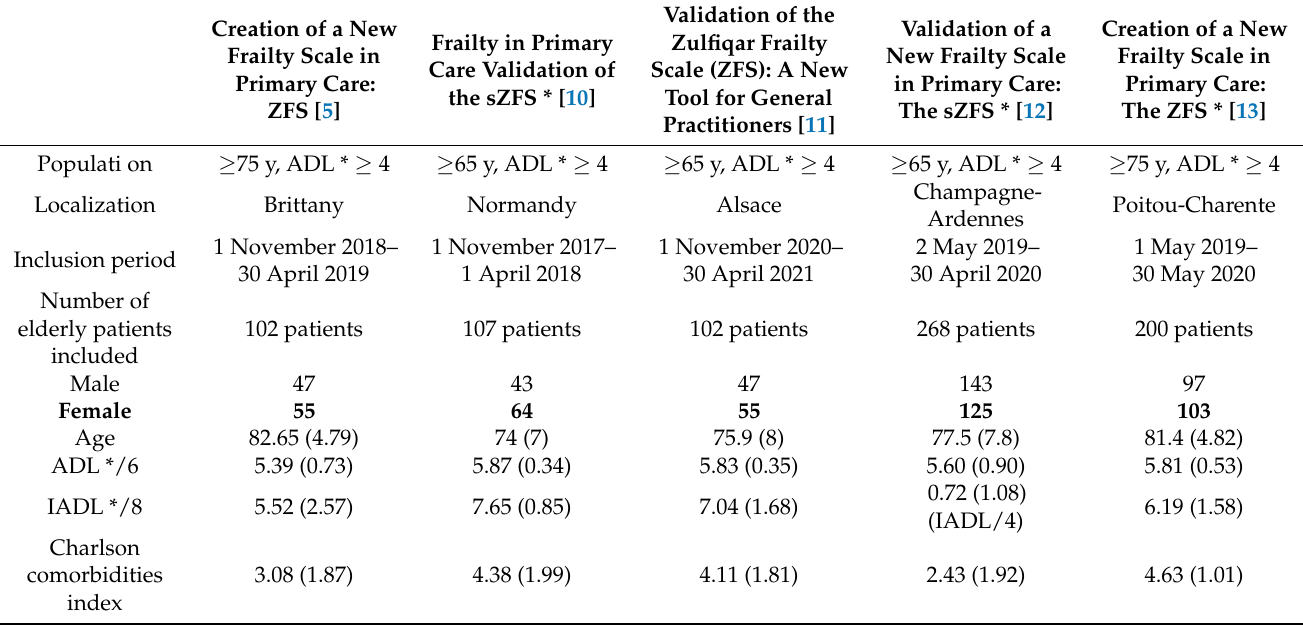
Table 2. Summary of the characteristics of the different studies and